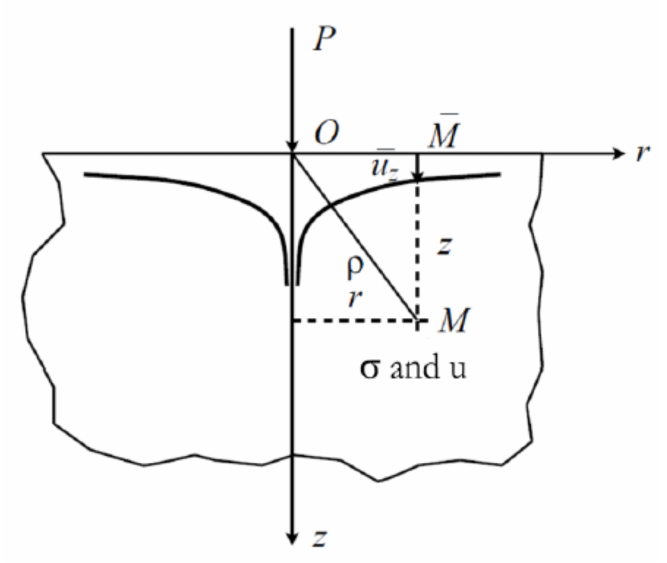
Figure 1. Description of the